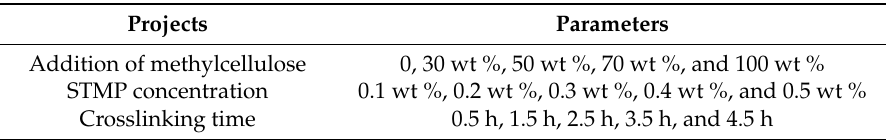
Table 1. The different samples with different reaction